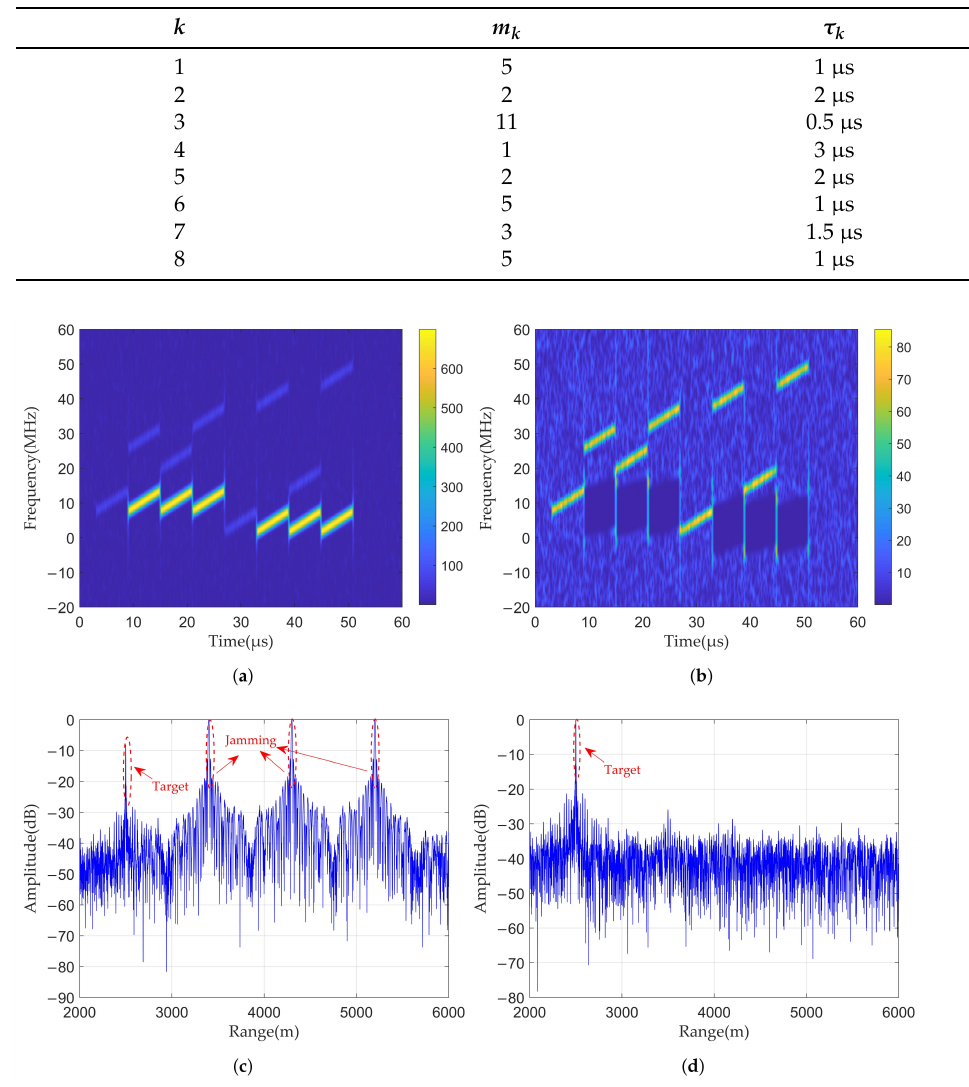
Figure 7. Suppression effect of Ref. [20] on ISRJ: ( a ) time–frequency distribution before suppres- sion, ( b ) time–frequency distribution after suppression, ( c ) pulse compression before suppression, ( d ) pulse compression after